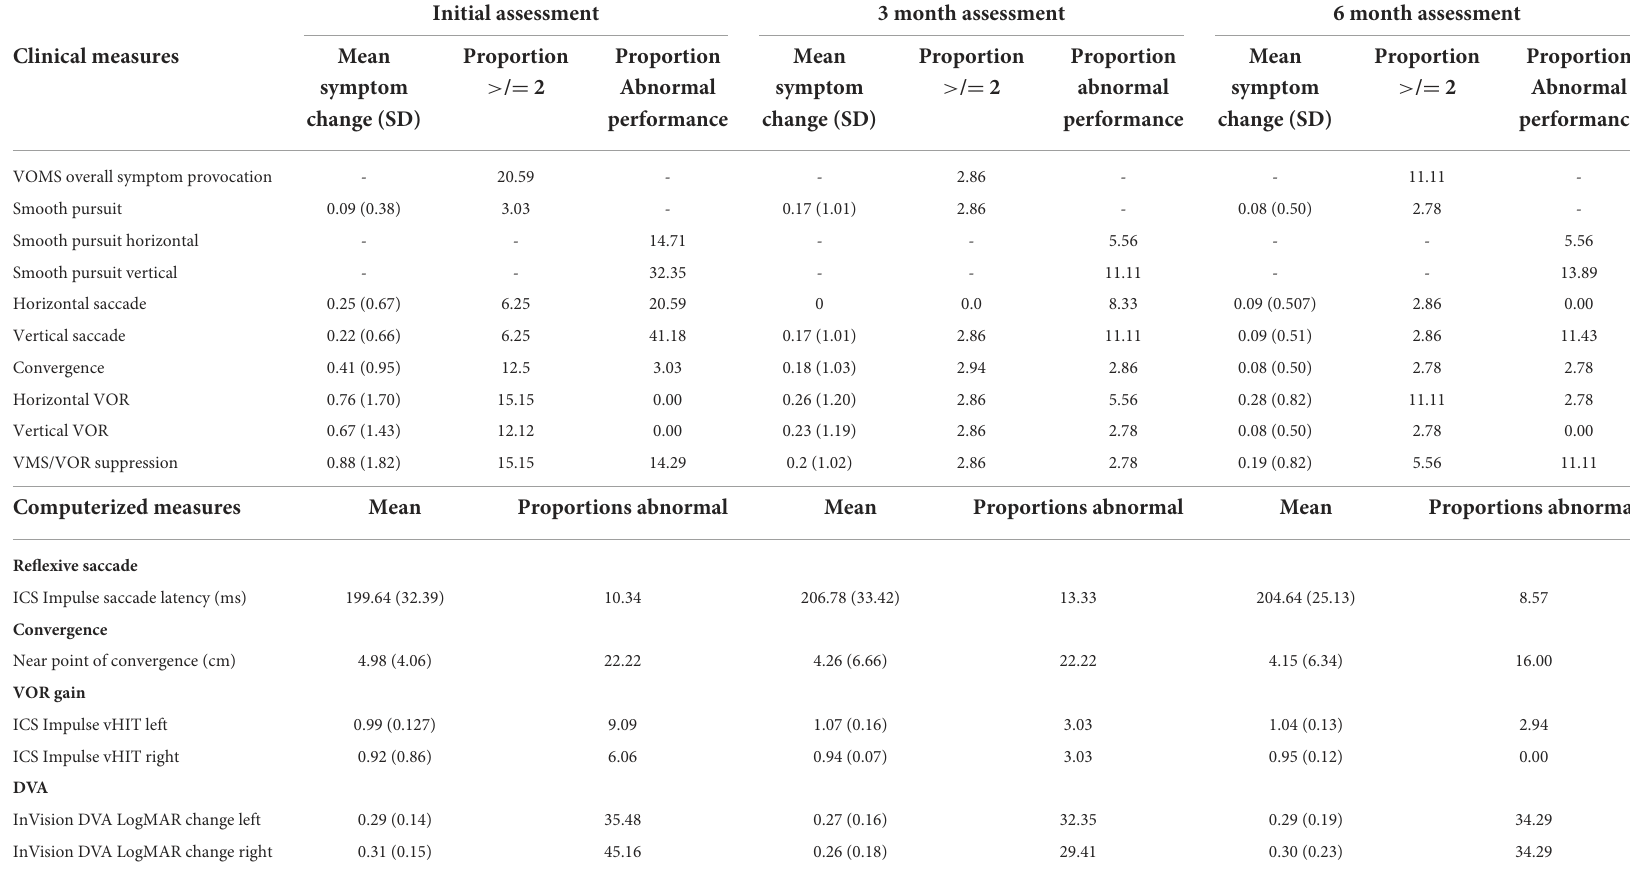
TABLE 4 Mean symptom change, proportions above symptom cut-offs and proportions demonstrating abnormal performance on oculomotor and vestibulo-ocular